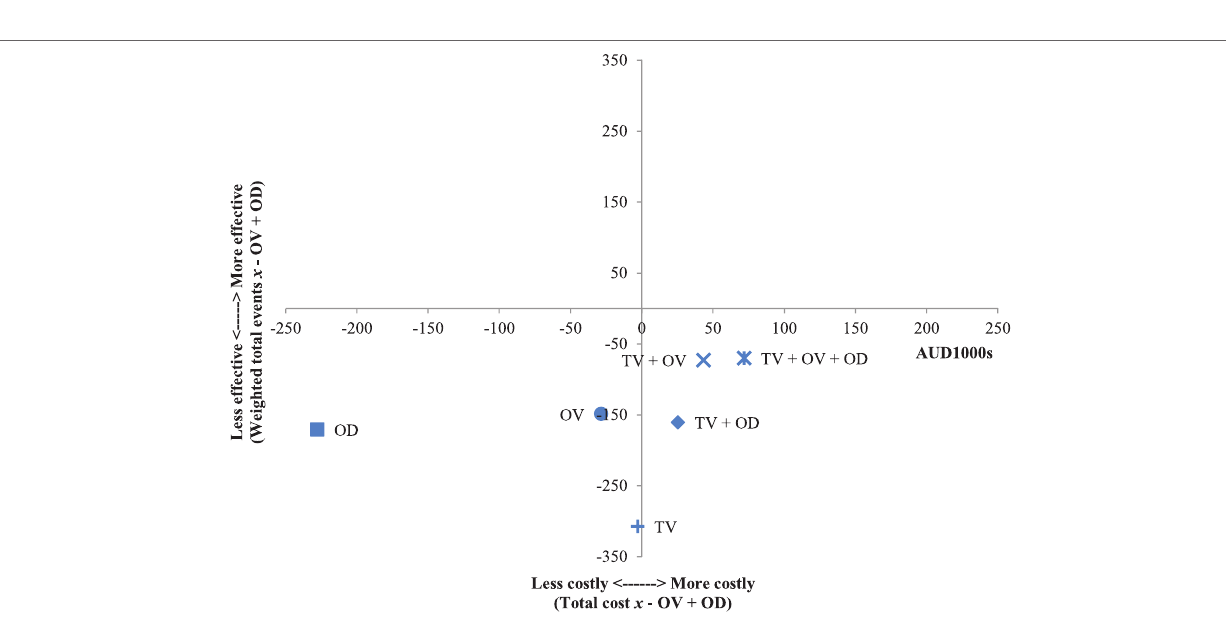
campaign website when exposed to materials via OD.